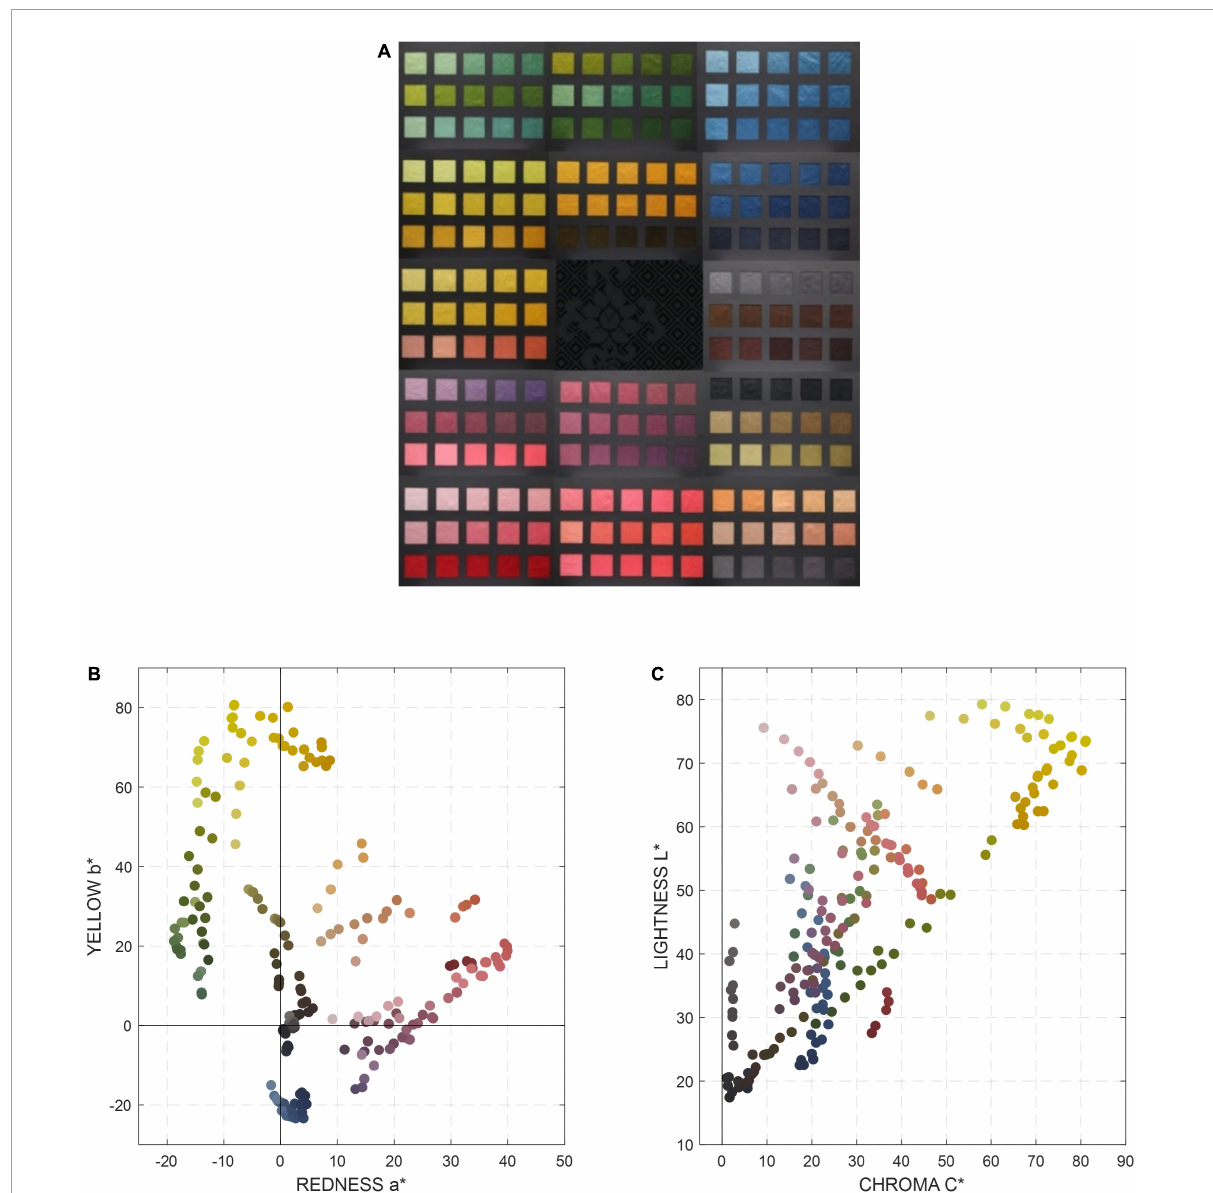
FIGURE1 The “Qianlong Palette” color chart (A) and the Color distributions of the “Qianlong Palette” color chart in CIELAB color space (B) a* b* plane and (C) L*C* plane.